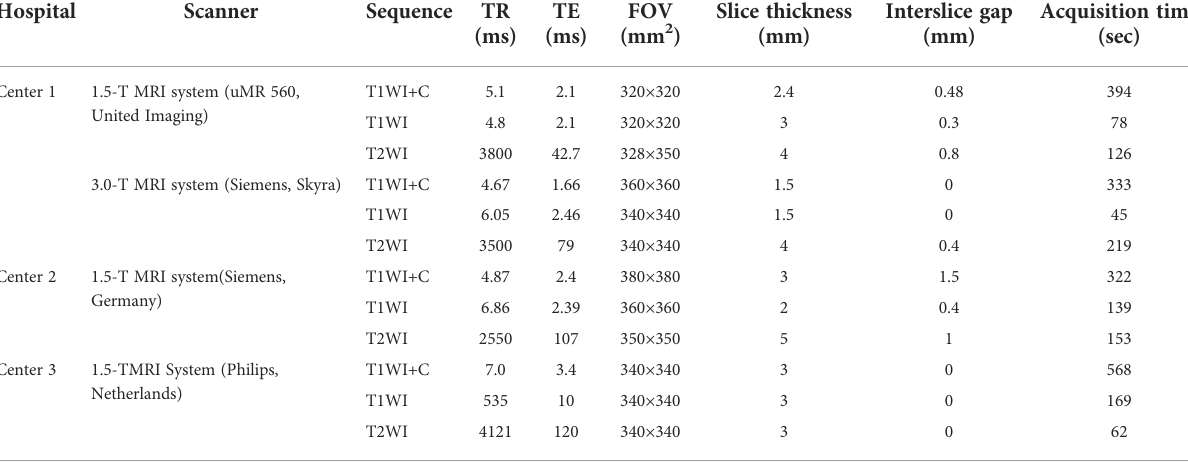
TABLE 1 Breast MRI sequences and acquisition parameters in three